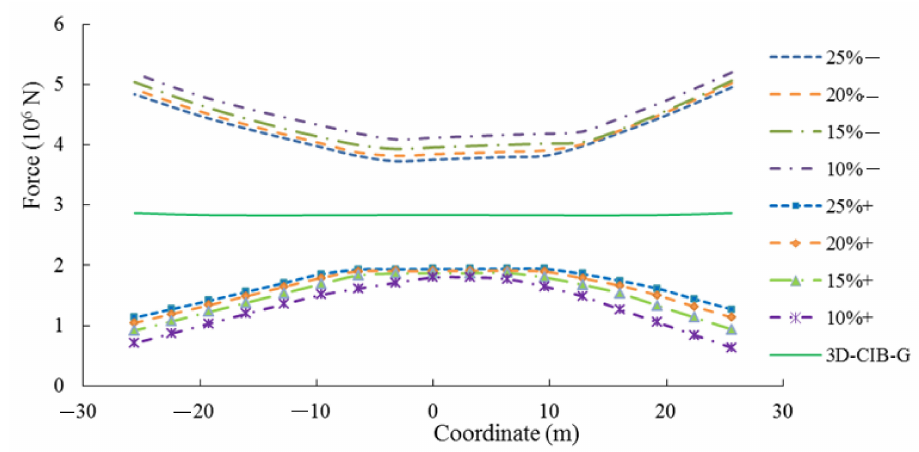
Figure 18. Comparison of the peak axial force of the 3D-CIBs along Y